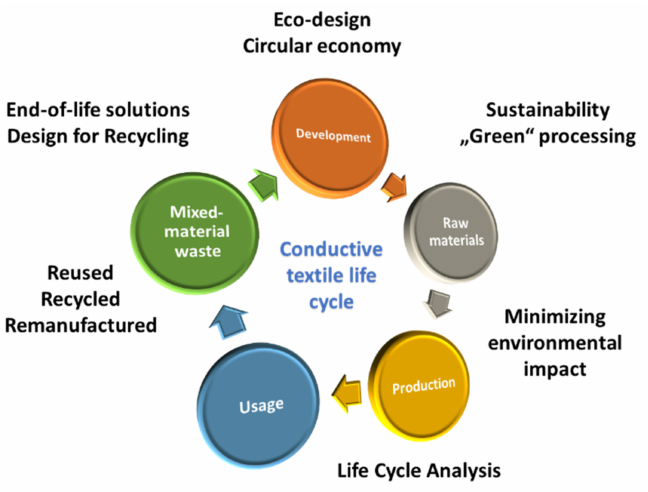
Figure 9. Scheme of life cycle of conductive textiles and their sustainable/recyclable